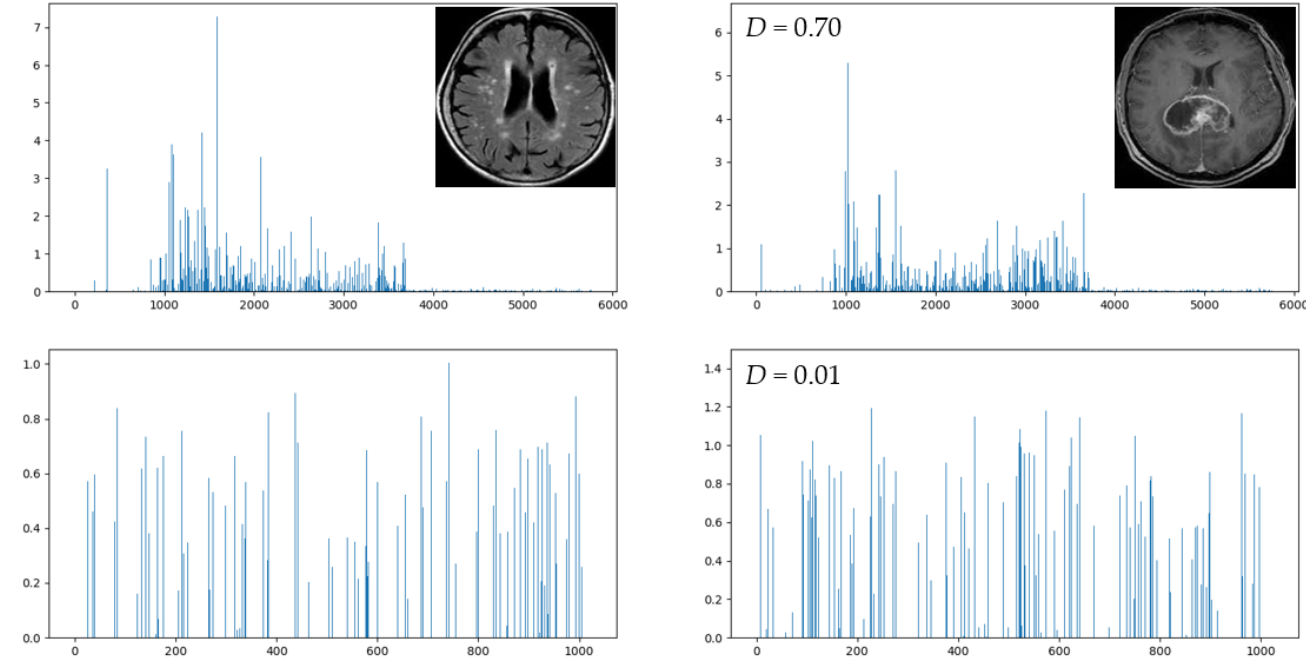
Figure 16. Examples of image features extracted using pretrained CNNs (upper rows) and using our proposed FS network (lower rows) in the case of two images from different classes (left: non-tumor brain image; right: tumor brain image).